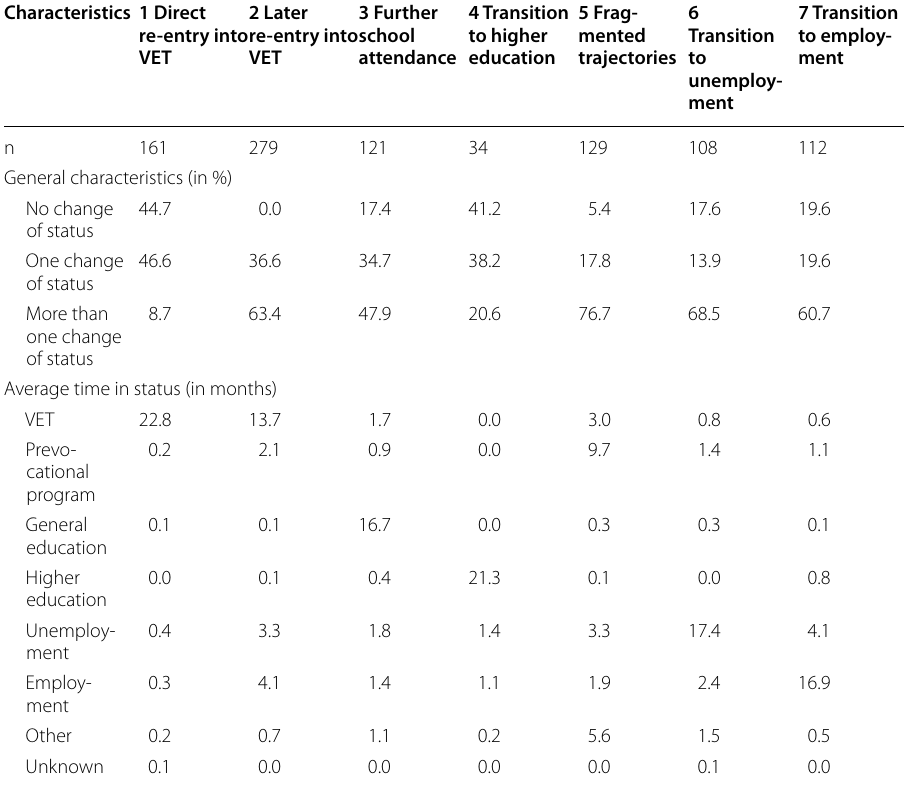
Table 4 Descriptive information of subsequent trajectory clusters within 24 months after PTT Characteristics 1 Direct 2 Later re‑entry into re‑entry into VET VET